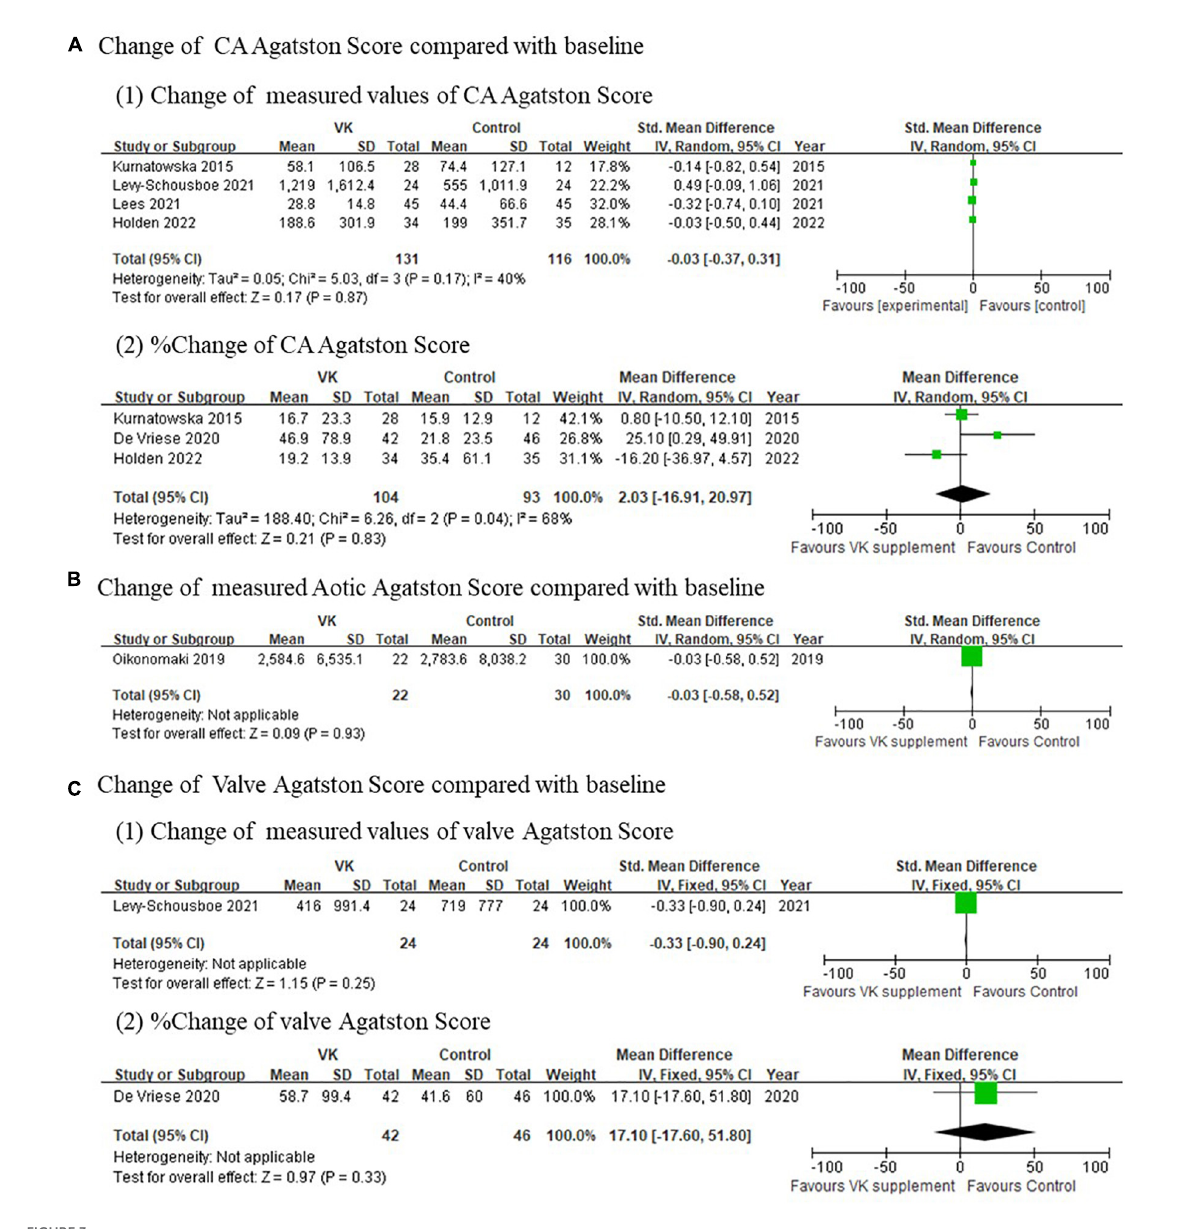
FIGURE3 Pooled changes Agatston scores of coronary artery (A) , aortic artery (B) , and valve (C) after Vitamin K supplementation compared with baseline.